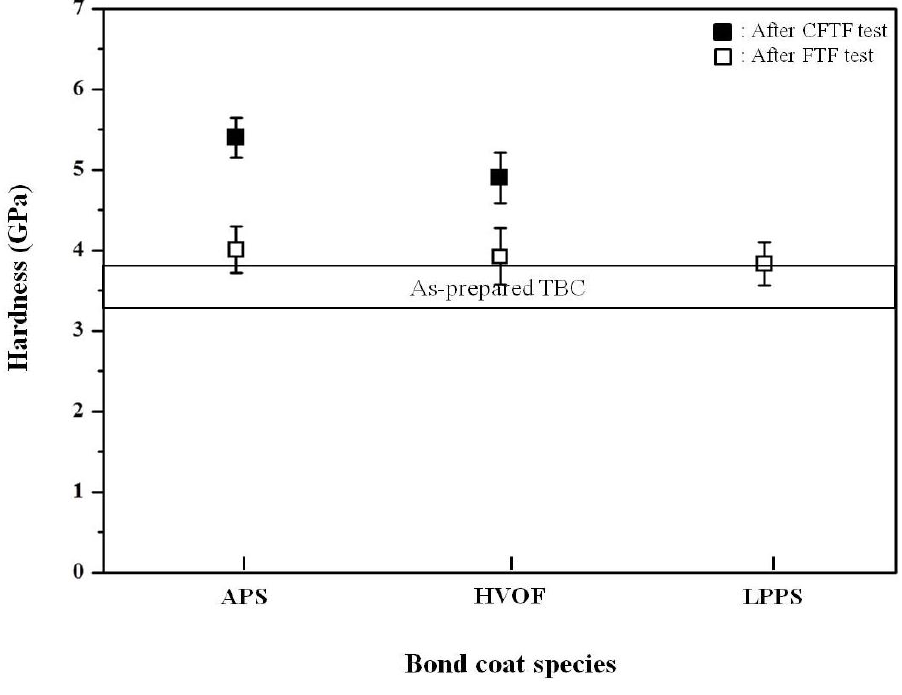
Figure 10. Hardness values of top coats before and after cyclic thermal exposure. Indentation for hardness was conducted on the sectional plane with a load of 3 N. The nominal value of as-prepared TBC was indicated inside figure. Filled and open marks indicate the hardness values after the CFTF and ETF tests, respectively.